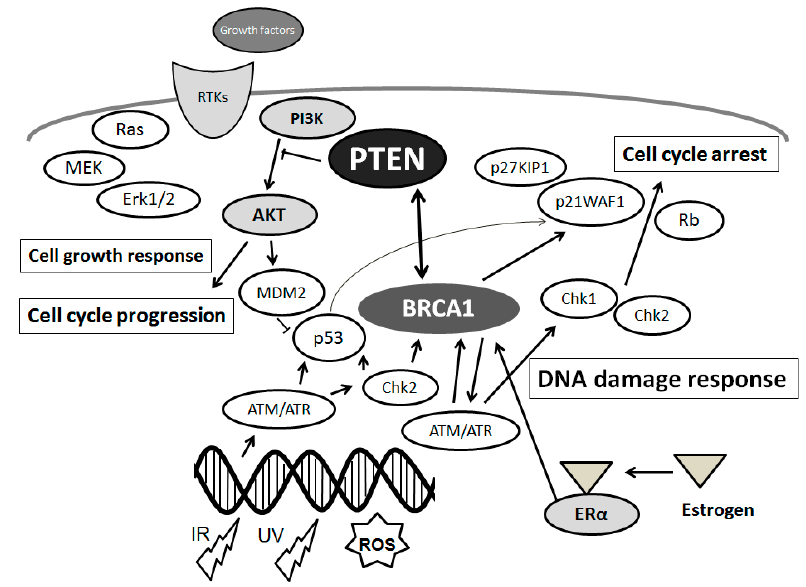
Figure 1. Schematic depiction of the integrative model of tumor suppressors signaling including PTEN and BRCA1 and implication of estrogen action, DNA damage, and DNA repair systems. Typical molecules known to act on DNA damage response, cell proliferation, and cell cycle via the regulatory pathways are shown. Arrowhead means stimulation whereas hammerhead represents inhibition. Note that some critical pathways have been omitted for clarity.